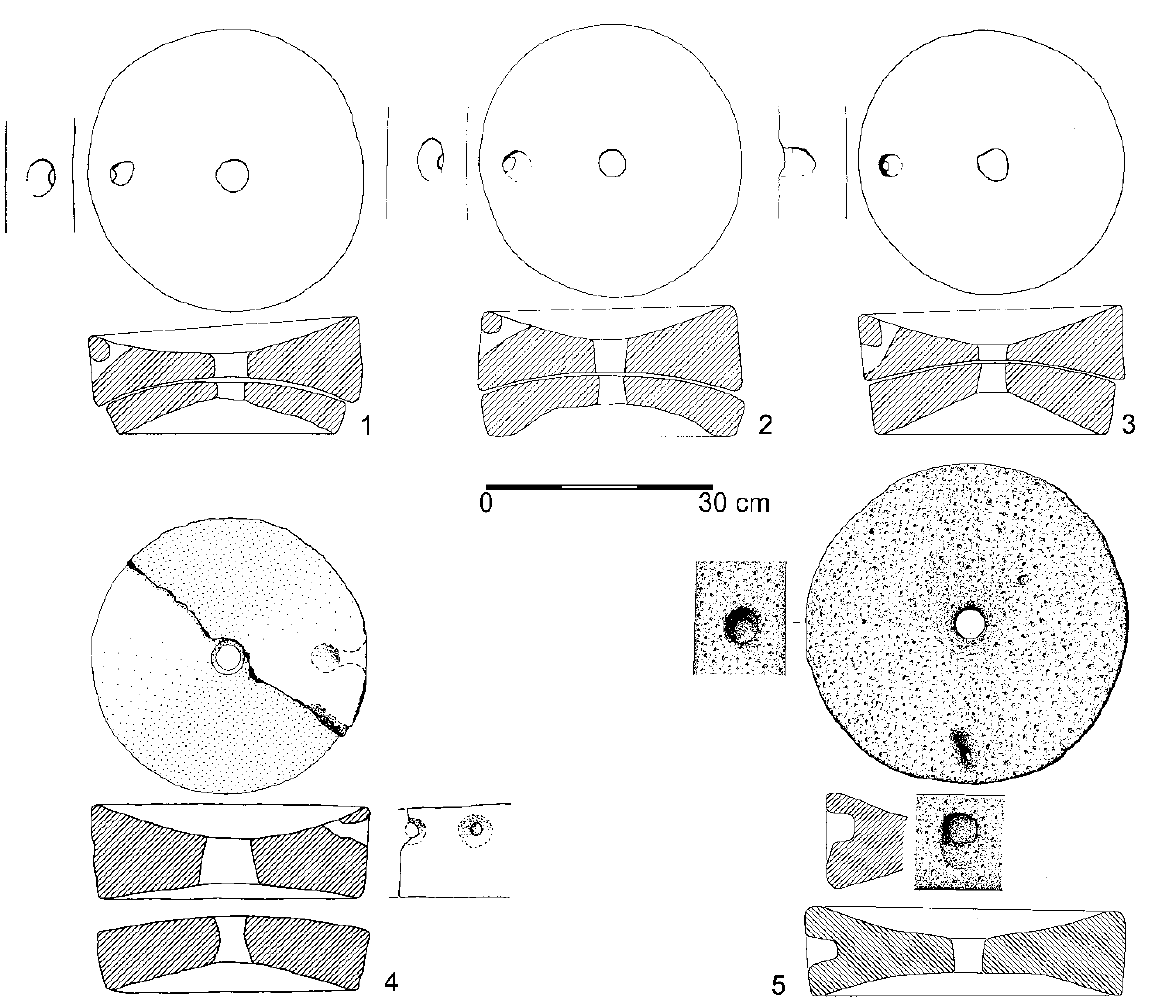
Figure 9. Quernsones of Brillerij type which are not dated by context. 1-4: upper and lower stones; 5: upper stone. Provenances: 1-3. Haaksbergen, Haaksberg veen; 4. Löhne-Mennighüffen; 5. Groesbeek. All “basalt”-like lava. (1-3. van Es & Verlinde 1977: fig. 75; 4. Bérenger 1983: fig. 50; 5. Hulst 1987: fig.